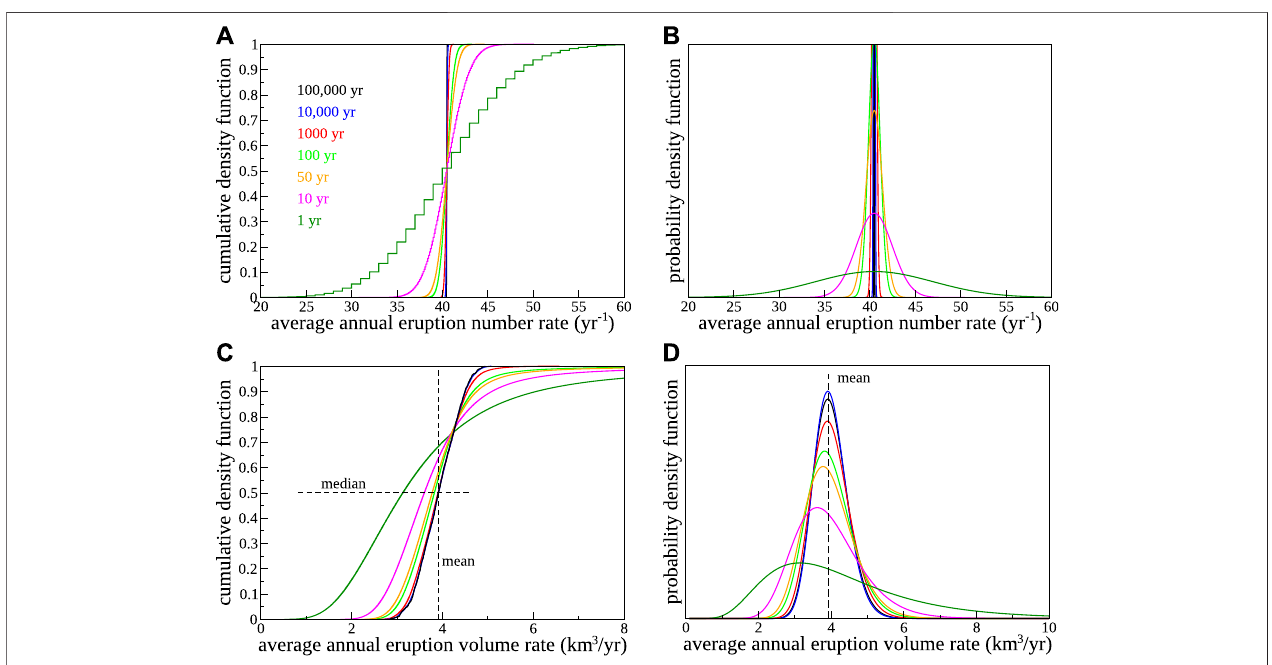
FIGURE2| Computeddistributionoftheannualeruptionnumber (A,B) andvolume (C,D) rates.Theleftpanelsshowthecumulativedensityfunction,whiletheright panels are probability density functions obtained by fi tting the cumulative distributions. For the non-normal volume rate distributions in panels (C,D) , the fi t is made to a skewed log-normal distribution by means of a method of moments estimator (Ghorbanzadeh et al., 2017) with computation of the Owen function as in Pate fi eld (2000). Thestep-wisecharacterofthecumulativedistributionfortheobservationaltimewindowof1 yearinpanel (A) isduetotheintegernatureofthenumberoferuptions observed over the same period of